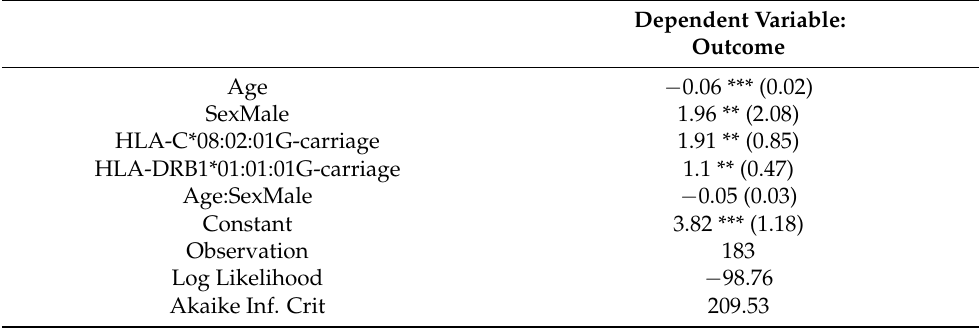
Table 16. Coefficients of «best» model by AIC with HLA allele, which were statistically significant at locus models.